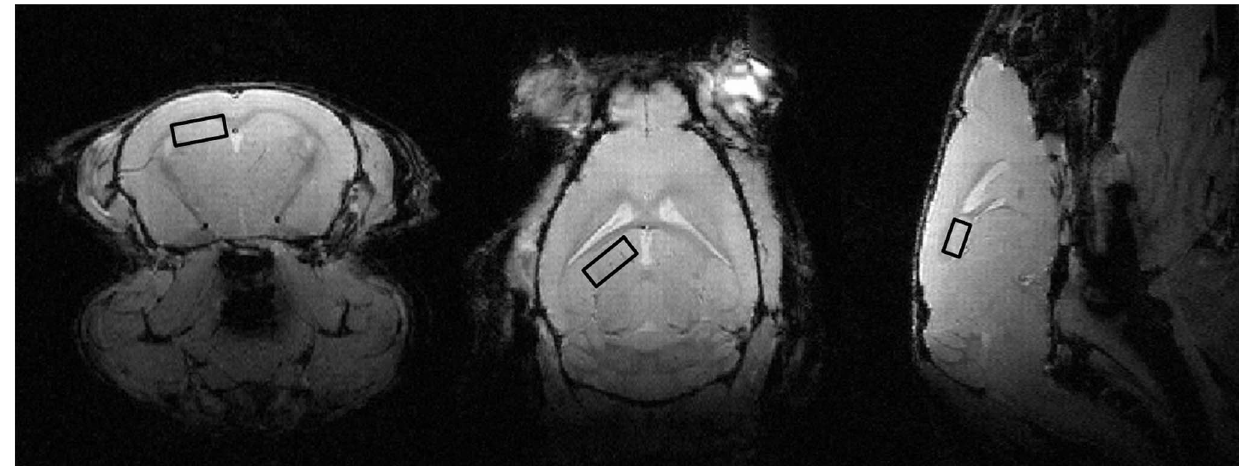
Figure 1. Localization of the spectroscopic volume of 1.0 6 1.0 6 1.6 mm placed in the hippocampus.